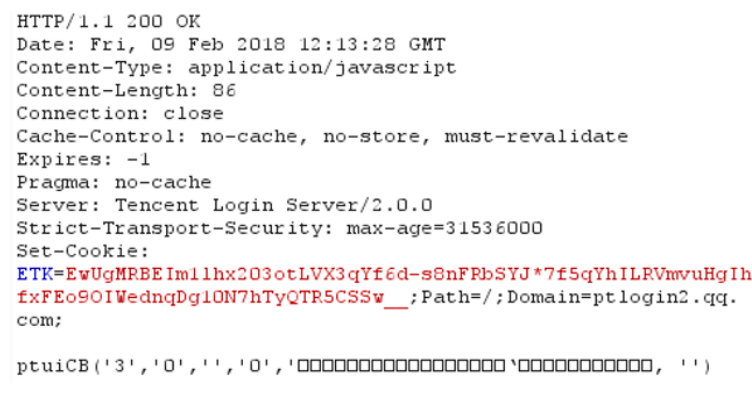
Figure 24. Response message.